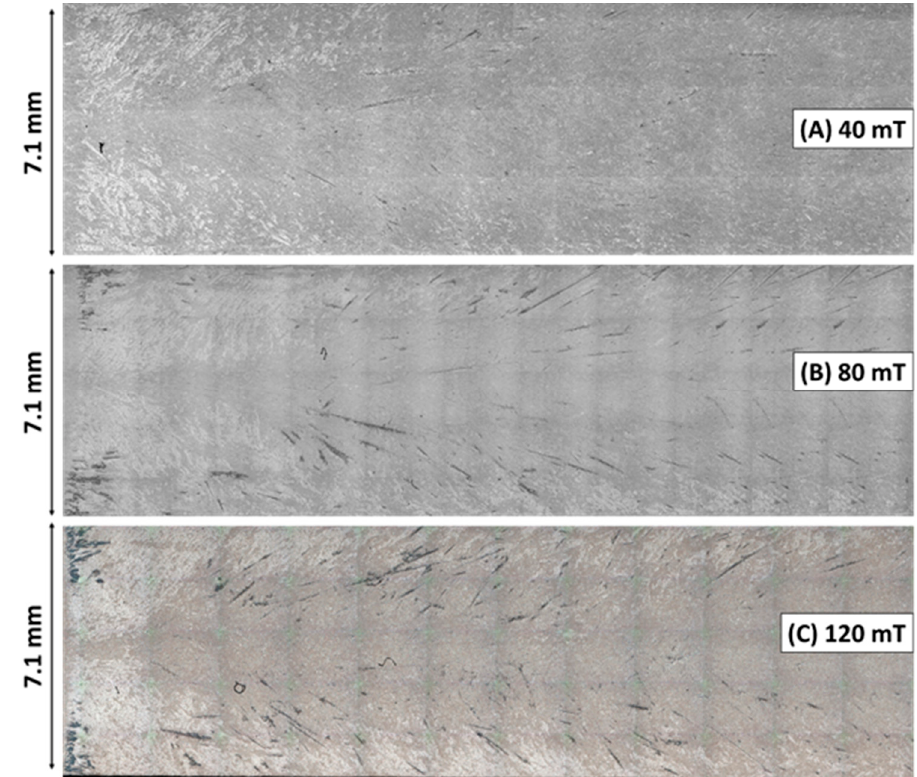
Figure 6. Macrostructures of solidified samples during step four of the solidification experiments (M = 50×); ( A ) step 4 of sample A, when 40 mT magnetic induction was applied. ( B ) step 4 of sample B, when 80 mT magnetic induction was applied. ( C ) step 4 of sample C, when 120 mT magnetic induction was applied.